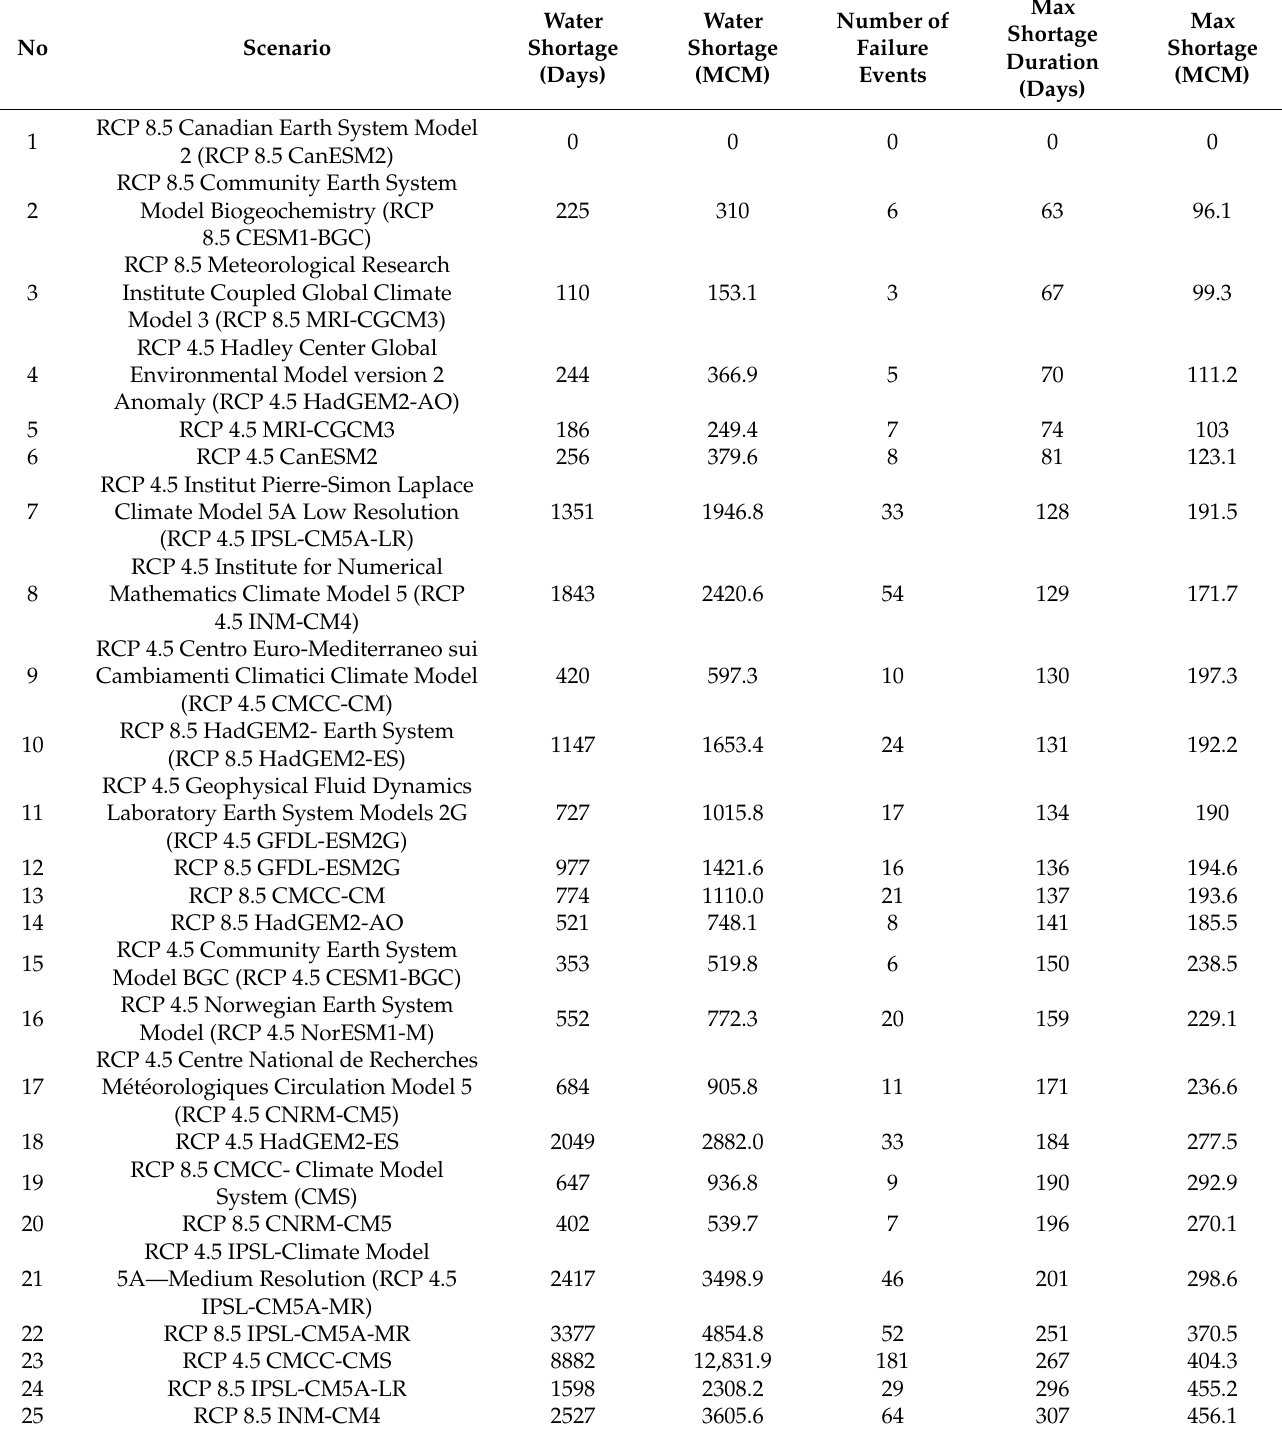
Table 4. A list of 25 future climate change scenarios and quantitative water supply capacity evaluation results for the Hapcheon reservoir. The maximum duration and the maximum shortage of water supply failure are the two crucial criteria that indicate the severity of